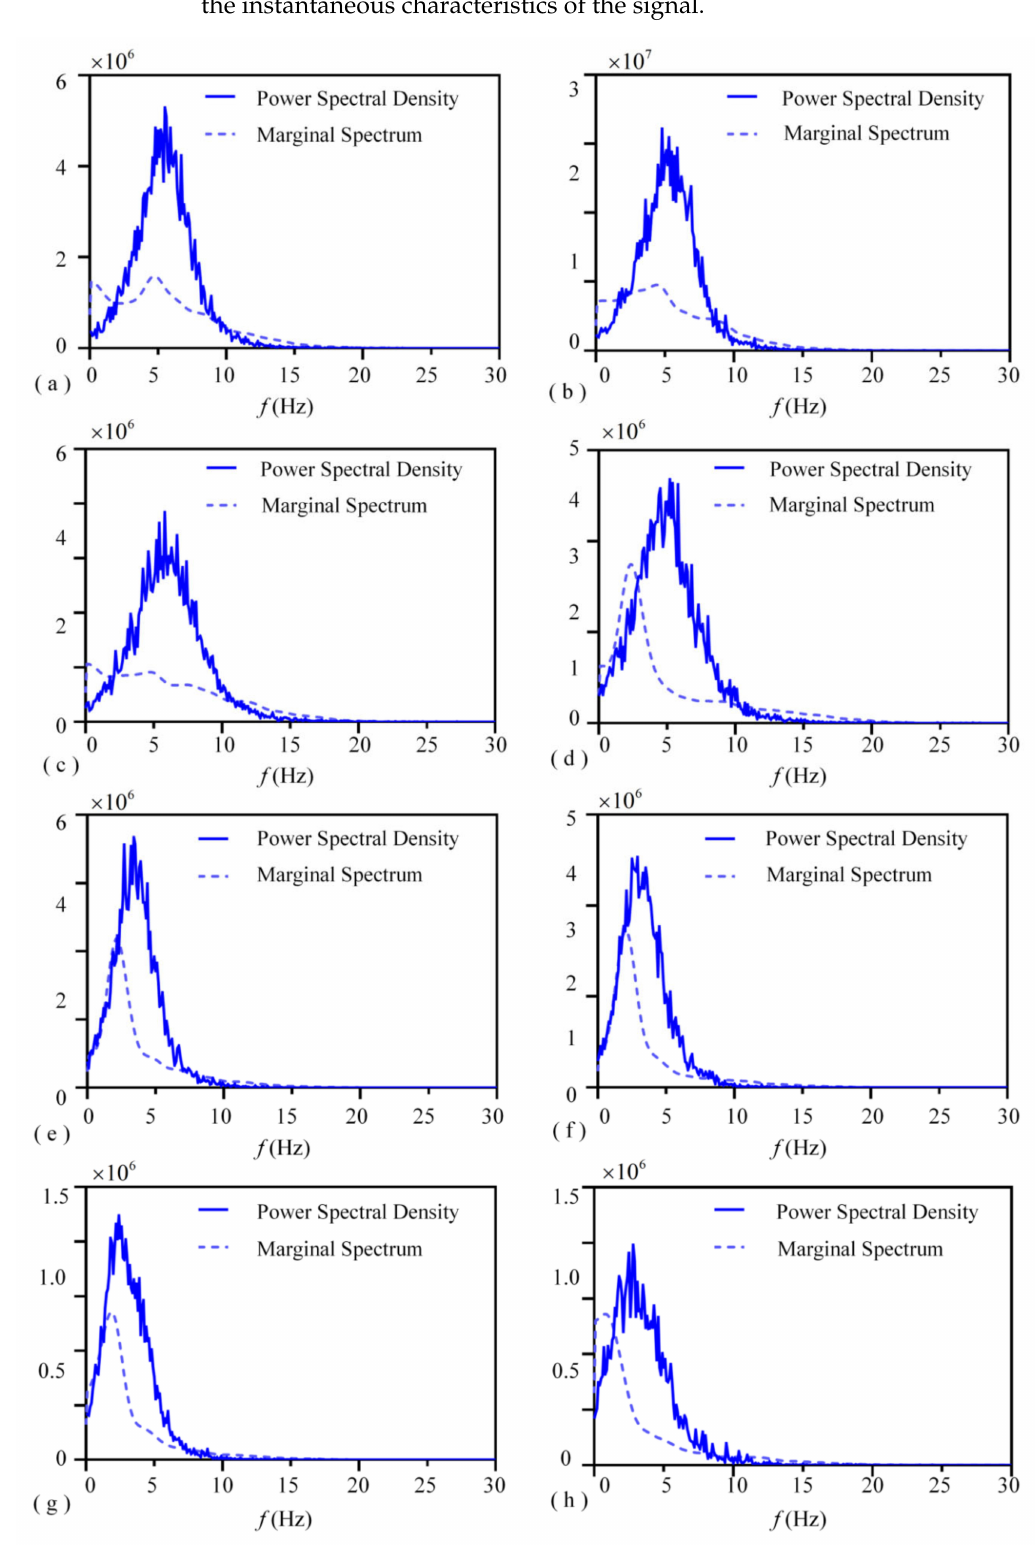
Figure 14. The stilling basin with a negative step marked TX4, when k = 0.0403, power spectrum density diagram and Hilbert marginal spectrum diagram of each feature point on the bottom of the stilling basin with a negative step. ( a ) x /L = 0.025; ( b ) x /L = 0.075; ( c ) x /L = 0.125; ( d ) x /L = 0.175; ( e ) x /L = 0.225; ( f ) x /L = 0.325; ( g ) x /L = 0.45; ( h ) x /L =